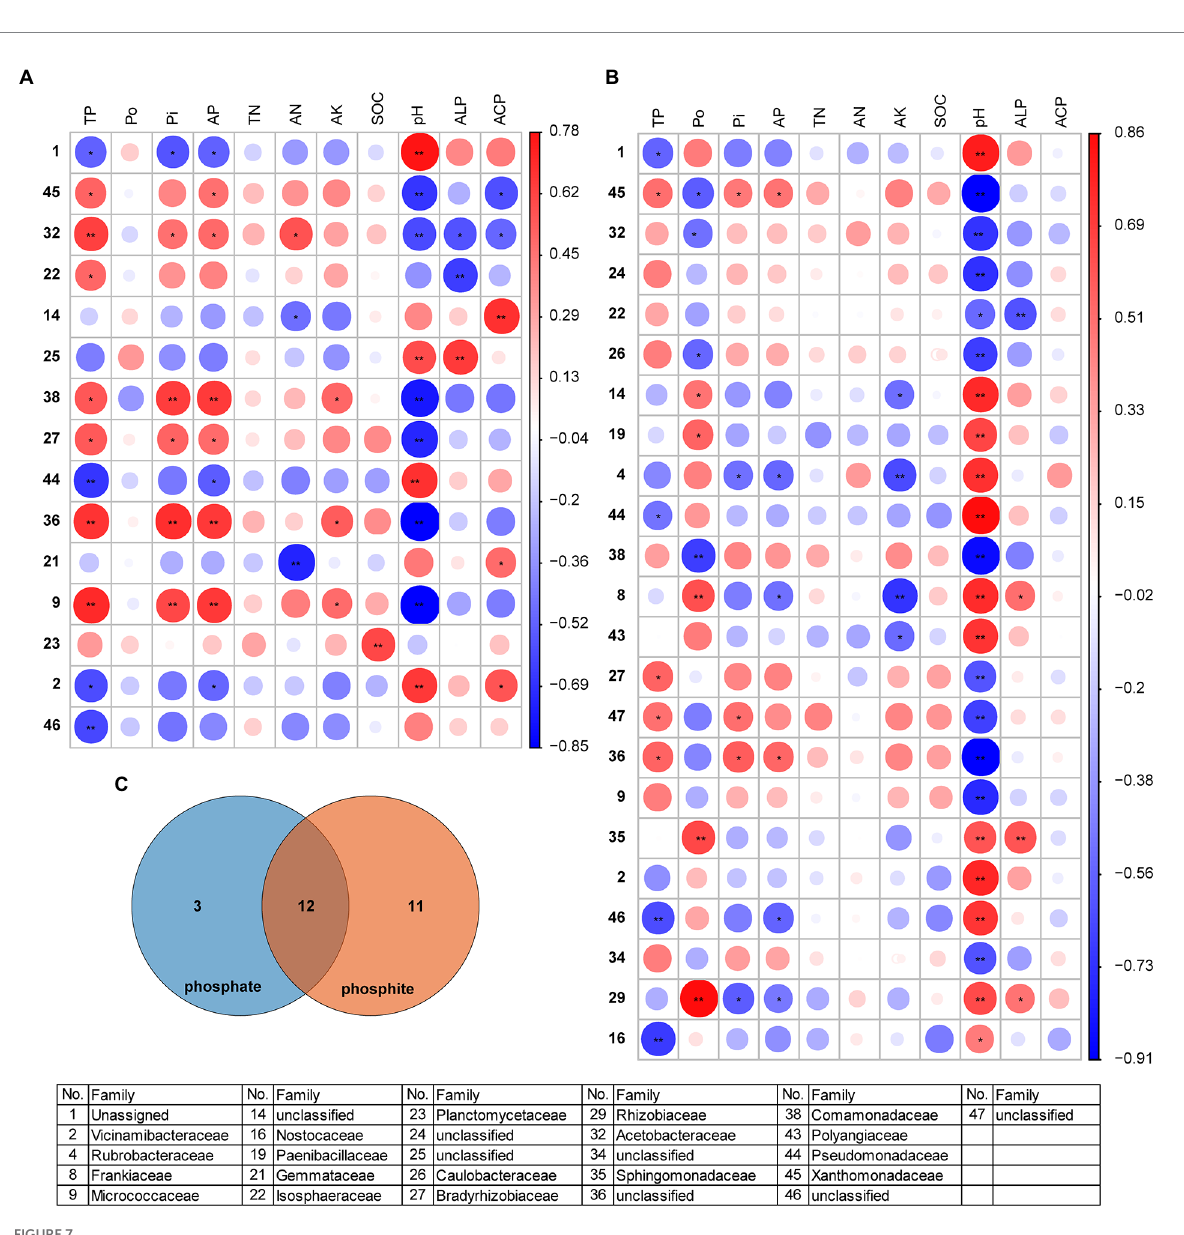
FIGURE 7 The matrix of the Spearman correlation coefficients showing the phoD -harboring bacterial families and soil physicochemical properties under phosphate fertilizer (A) and phosphite fertilizer (B) . Venn diagram of the families under phosphate- and phosphite-treated field (C) . The circle indicates larger correlation coefficients, and only significant correlations ( p < 0.05) are included. See Figure 2 for the defined abbreviations. The asterisk “*” represents significant relationships ( p < 0.05), while “**” represents highly significant relationships ( p < 0.01). The coefficient Spearman correlation ranges from − 0.85 (blue) to 0.78 (red) under phosphate fertilizer and − 0.91 (blue) to 0.86 (red) under phosphite